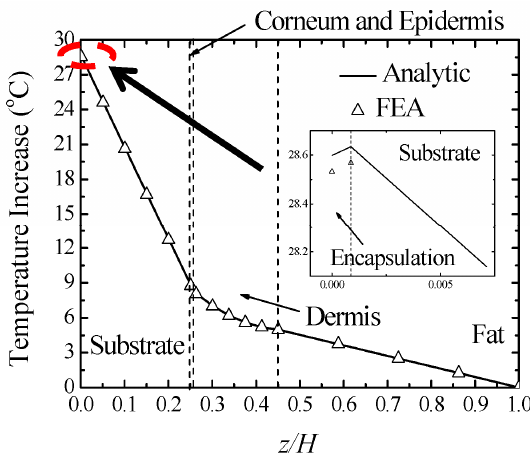
Figure 2. The comparison of temperature increase along the thickness direction between the analytic prediction and finite element analysis with the total thickness H = 8.007 mm. prediction and finite element analysis with the total thickness H = 8.007